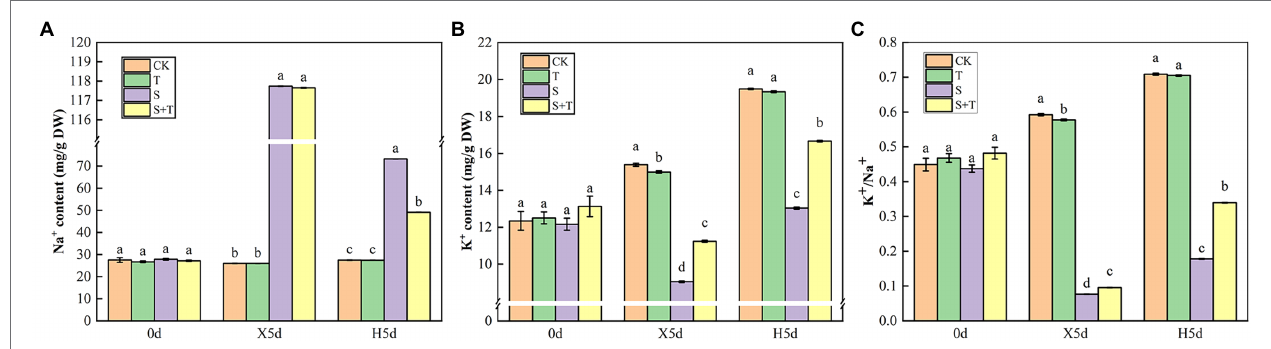
FIGURE 10 | Effects of foliar-applied trehalose on ion content of tomato leaves under stress and non-stress conditions. (A) Na + content. (B) K + content. (C) K + /Na + ratio. The results showed the mean ± SE of three replicates, and the different letters denote the significant difference among treatments ( p < 0.05), according to Duncan’s multiple test. CK, control; T, 10 mM trehalose; S, 150 mM NaCl; S + T, 150 mM NaCl + 10 mM